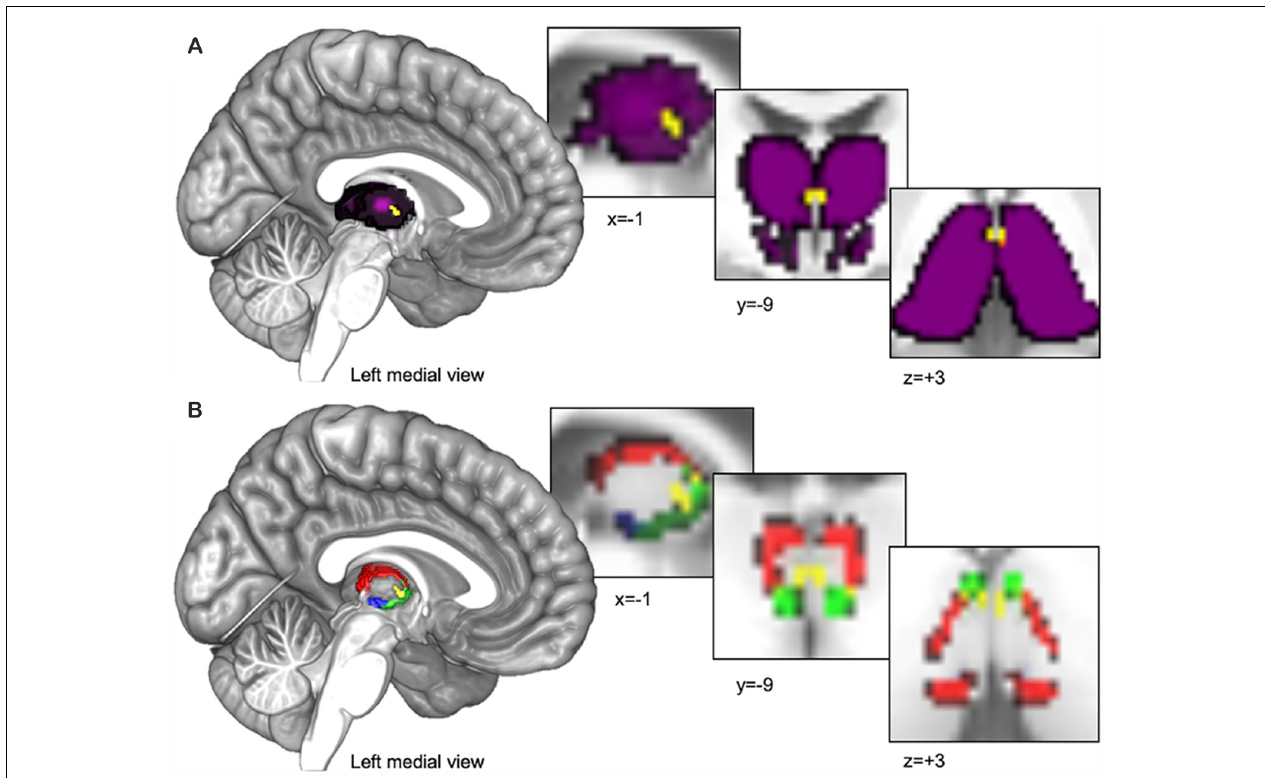
FIGURE 1 | Thalamus seed regions entered into functional connectivity analyses. (A) The Paraventricular Thalamic Nucleus (PVT) seed (shown in yellow) surrounded by the rest of the thalamus (shown in purple). The purple seed region encompassing the rest of the thalamus was used for the analyses presented in Figures 2 – 4 . (B) In separate analyses, we also compared PVT connectivity with nearby midline thalamic subnuclei CeM (green), CL (red), and the Pf (blue; see Figures 5 , 6